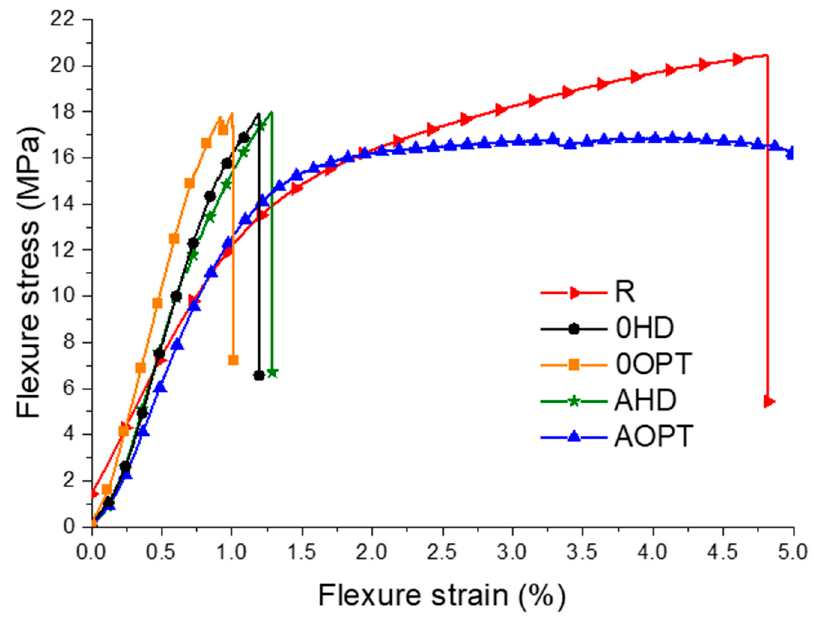
Figure 6. Flexure stress–strain of all sandwich’s structures.